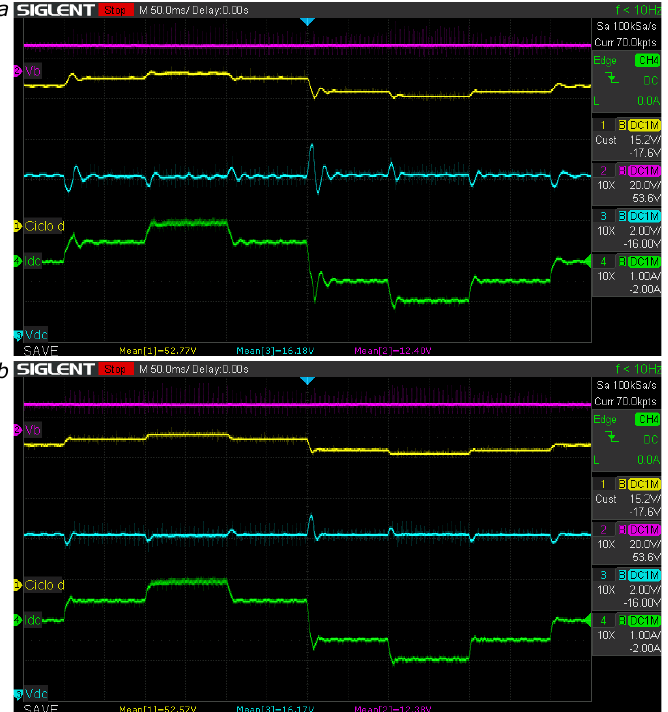
= 16 V (boost mode) using ( a ) PI and ref